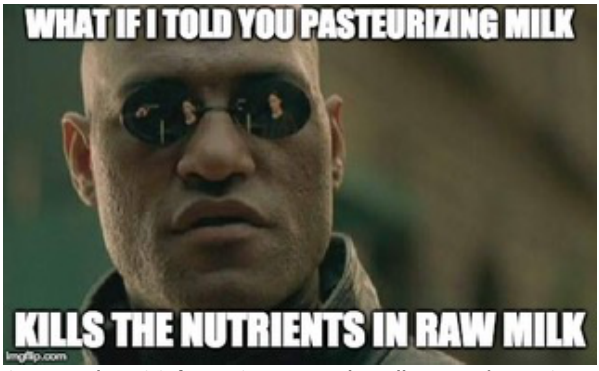
Figure 5: The Misinformation Meme that all Respondents